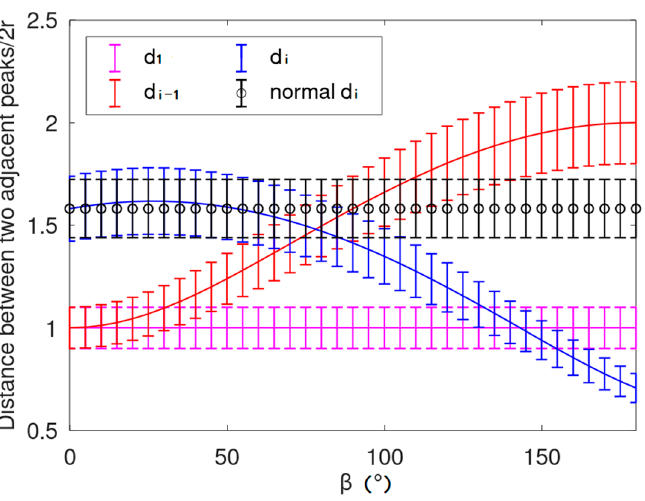
Figure 14. Distance between the two adjacent peaks. The mean distance between the two adjacent peaks is 2 × r as d 1 .